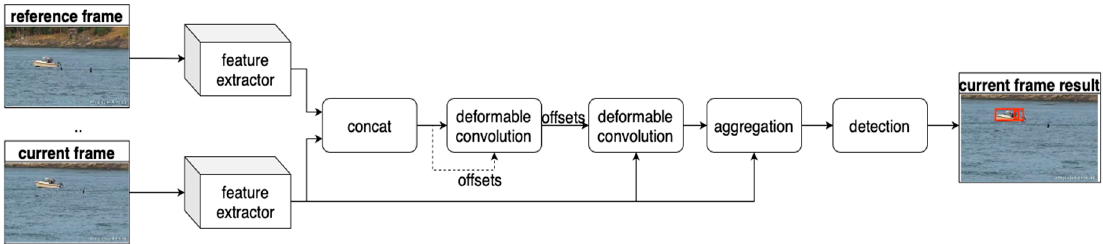
Figure 10. STSN (spatiotemporal sampling networks) framework [83].